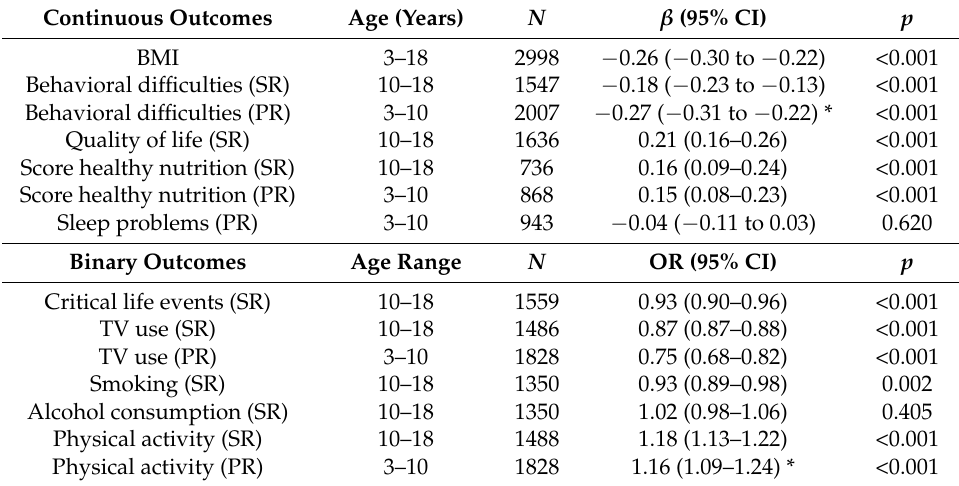
Table 3. Associations of SES (as indicated by the SES composite score) with health outcomes and behaviors in